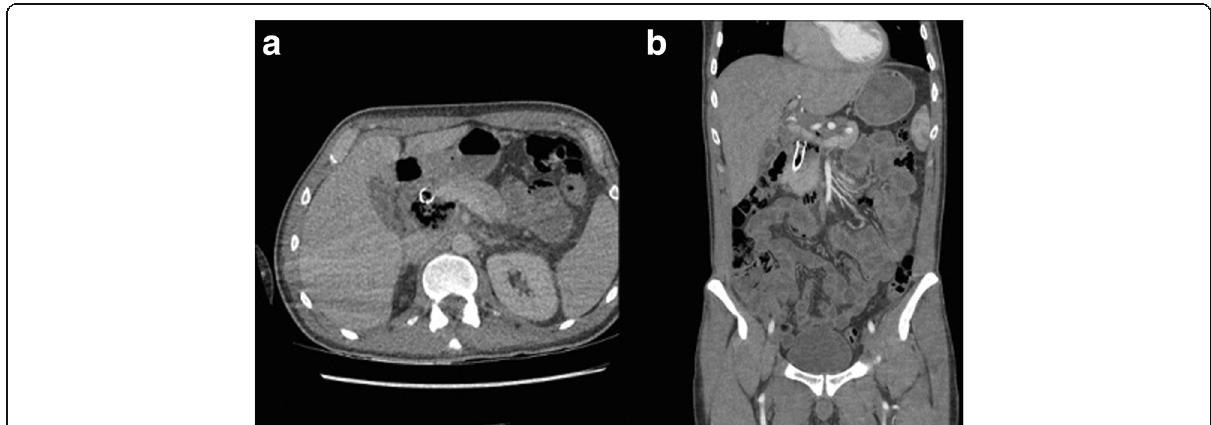
Fig. 2 Abdominal CT following one dose of chemotherapy showing necrosis of the periportal nodal mass and erosion of the stent through the bile duct